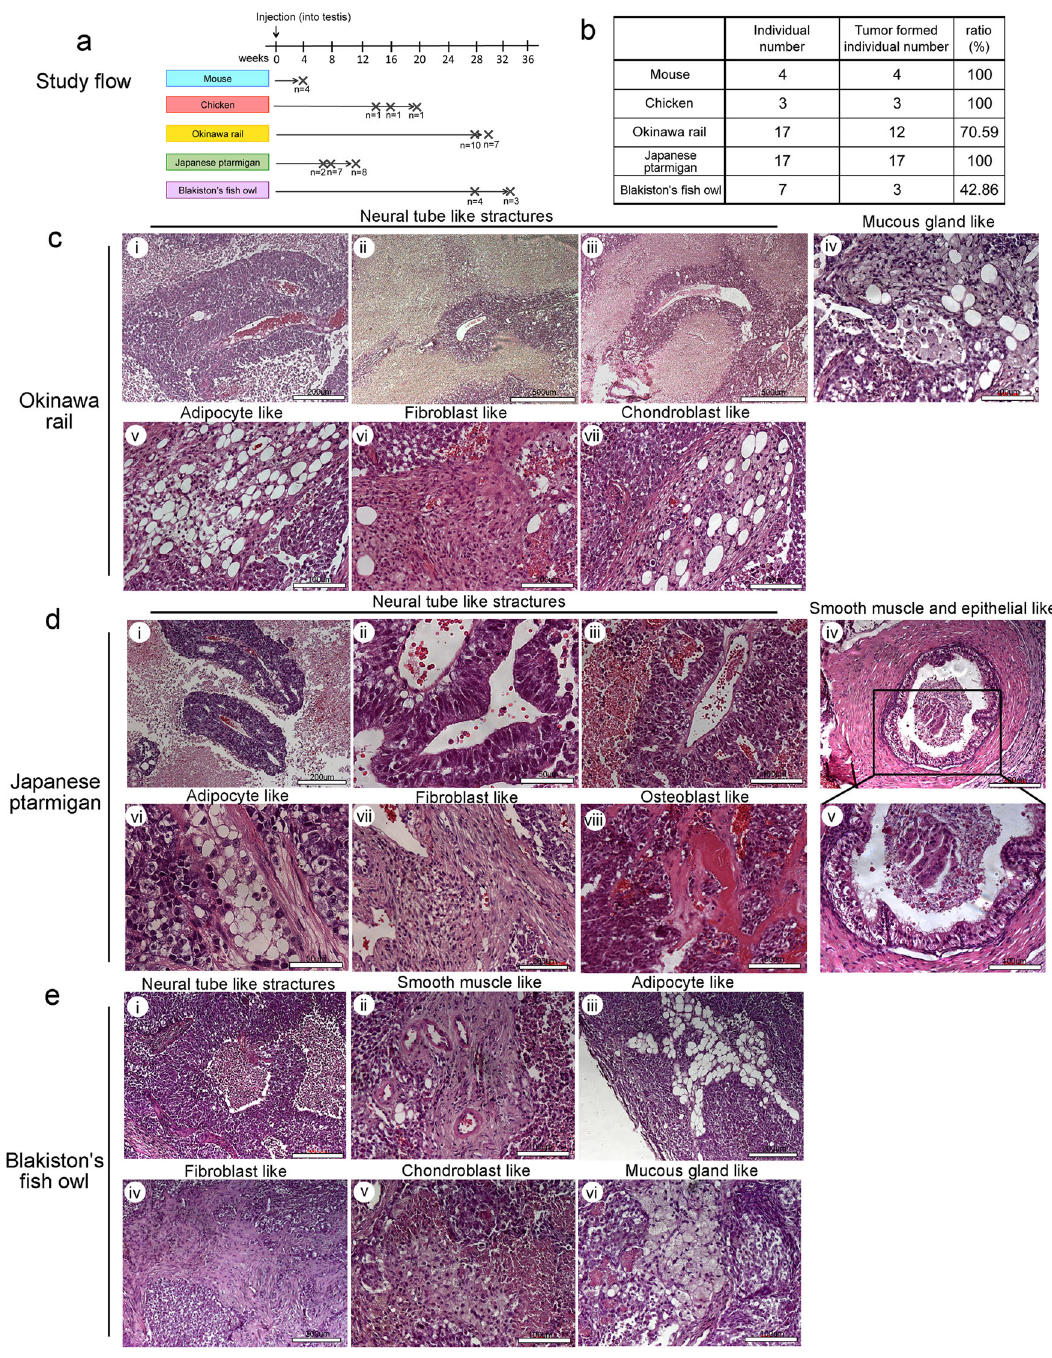
Fig. 6 In vivo differentiation of established mouse, chicken, Okinawa rail, Japanese ptarmigan, and Blakiston ’ s fi sh owl-derived iPSCs. a Tumors that formed in testis tissue of SCID mice. b Tumor formation ratio. Histological analysis of Okinawa rail ( c ), Japanese ptarmigan ( d ), and Blakiston ’ s fi sh owl ( e ) iPSC-derived teratomas. Various tissues originating from the three germ layers were identi fi ed and included neural tube-like structure (ectoderm) ( c i, c ii, c iii, d i, d ii, d iii, and e i), adipocyte-like structure (mesoderm) ( c v, d vi, and e iii), fi broblast-like structure (mesoderm) ( c vi, d vii, and e iv), chondroblast-like structure (mesoderm) ( c vii, and e v), osteoblast-like structure (mesoderm) ( d viii), smooth muscle-like structure (mesoderm) ( d iv, and d v), mucous gland- like structure (endoderm) ( c iv, and e vi), and epithelial-like structure (endoderm) ( d iv, and d v). The tissues were then stained with hematoxylin and eosin. Bars indicate 50 – 500 μ